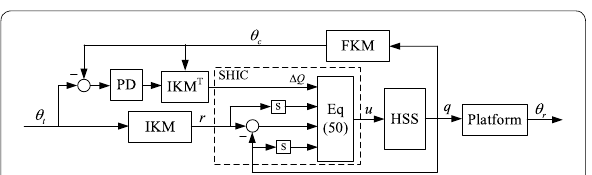
Figure 7 Compound impedance control of parallel mechanisms. PD: Proportional differential, FKM: Forward kinematics model, KIM: Inverse kinematics model, KIM − 1 : Dynamic mapping matrix, HSS: Hydraulic Servo System, SHIC: Single Channel Impedance Control